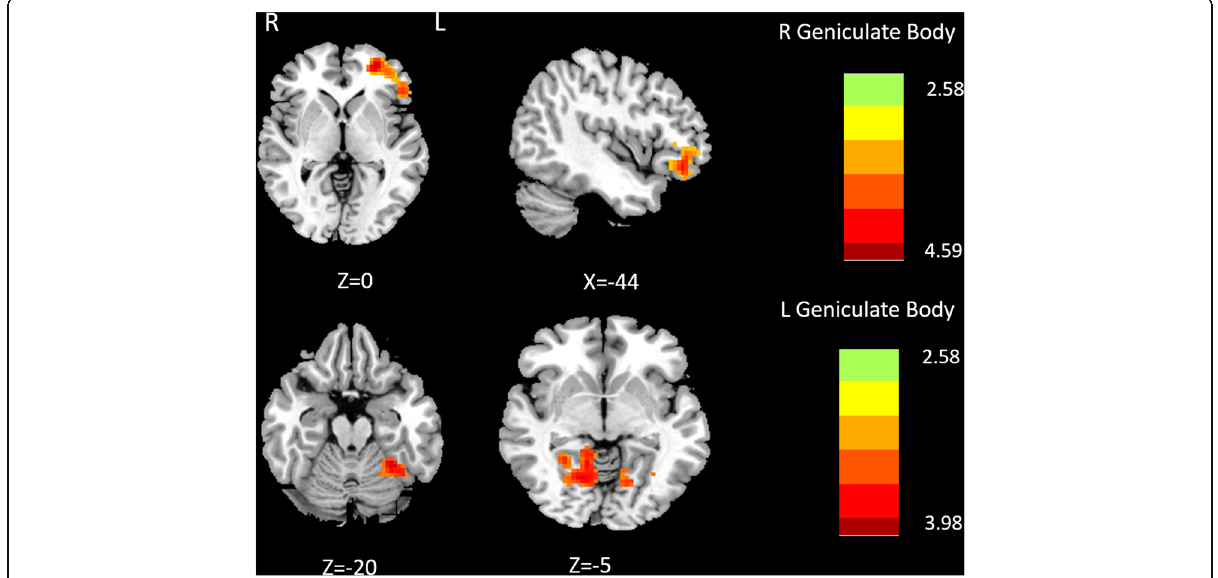
Fig. 2 Comparison of FC of lateral geniculate nucleus between MwoA and HC. Warm color represents altered functional connectivity. MwoA patients showed increased functional connectivity compared with HC (red areas), full list of structures in Table 2. The right side of the brain refers to the left hemisphere and vice versa. The axial image was overlaid on the transverse section of the MNI-152 standard anatomical image. The z coordinate of each slice in the MNI-152 standard space is